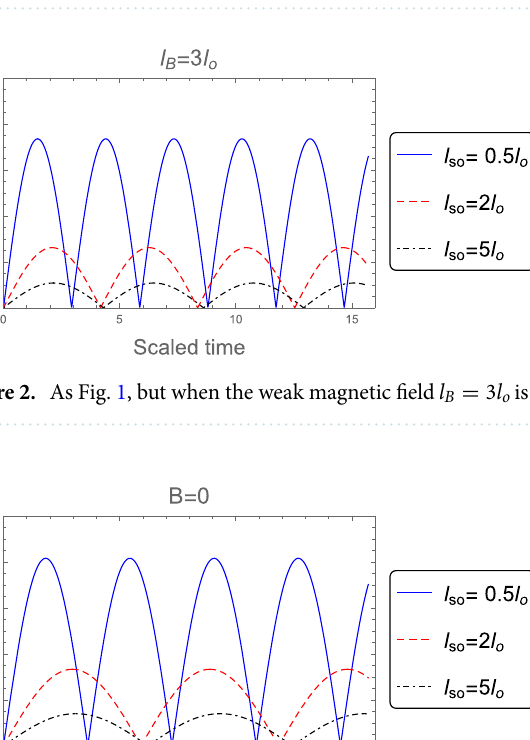
Figure 1. The orthogonality, S or , when the system’s initial state in the pure state values of SOC strength l so